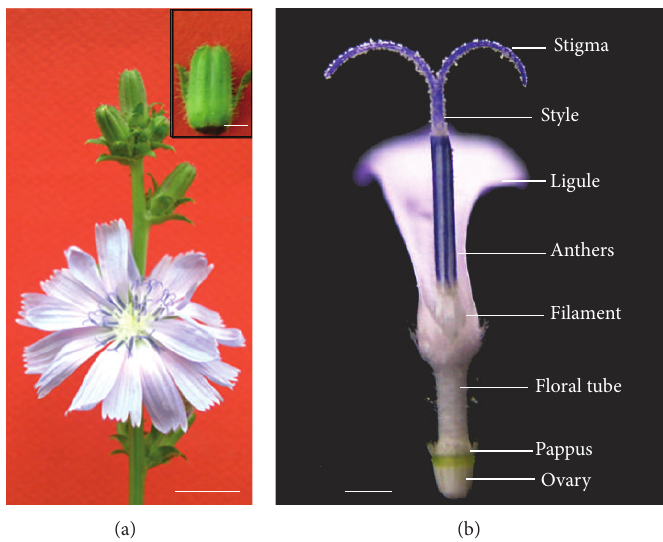
Figure 2: Overview of inflorescence and fertile flower structure. (a) Various stages of capitulum development on a branch with an opened capitulum at anthesis showing ligulate florets. Inset: capitulum with the external bracts partially removed prior to length measurement. (b) The anthers form a column through which the stylar branches and style move upward brushing the pollen grains. The stamens are attached to the ligule and the inferior ovary bears a scaly pappus. Bars (a) 1cm, inset 1 mm, (b) 1 mm.